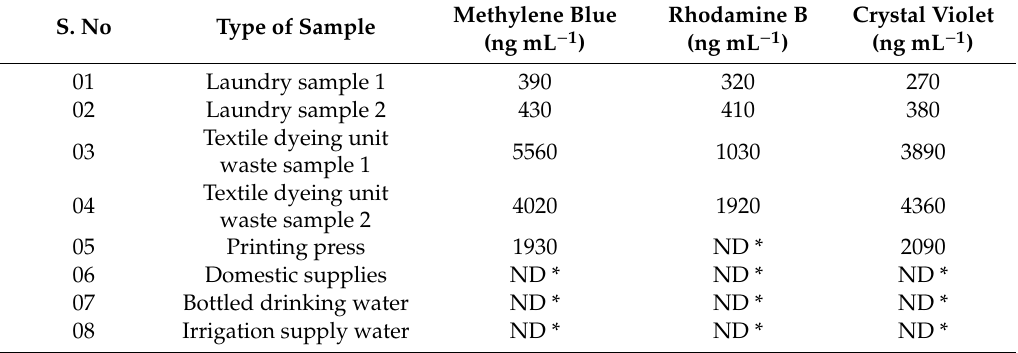
Table 6. Determination of methylene blue, crystal violet and rhodamine B in environmental samples. Methylene Blue Rhodamine B Crystal Violet S. No Type of Sample (ng mL − 1 ) (ng mL − 1 ) (ng mL − 1 ) 01 Laundry sample 1 390 320 270 02 Laundry sample 2 430 410 380 Textile dyeing unit 03 5560 1030 3890 waste sample 1 Textile dyeing unit 04 4020 1920 4360 waste sample 2 05 Printing press 1930 ND * 2090 06 Domestic supplies ND * ND * ND * 07 Bottled drinking water ND * ND * ND * 08 Irrigation supply water ND * ND * ND * * ND: not